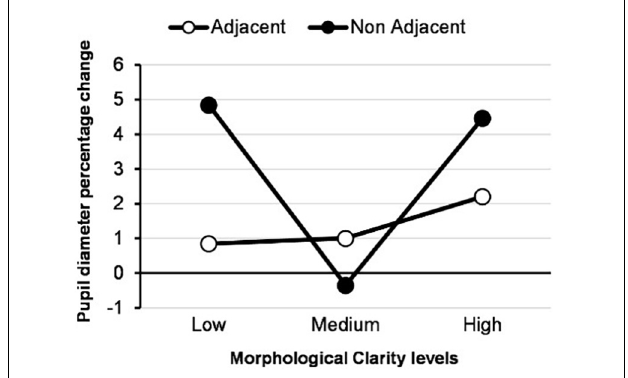
FIGURE 7 | Percentage change of pupil diameter by each type of